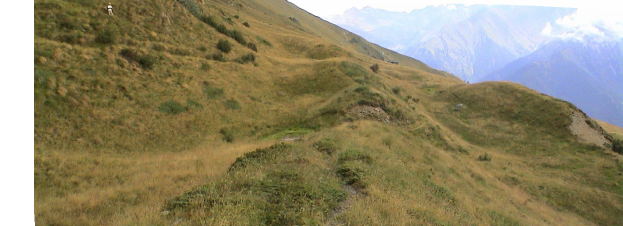
Figure 8. Watershed of tributary of the Soana stream, incised in a deep-seated slope collapse deposit; typical features include trenches and counterslope surfaces, often with emergent water (photo 31 July